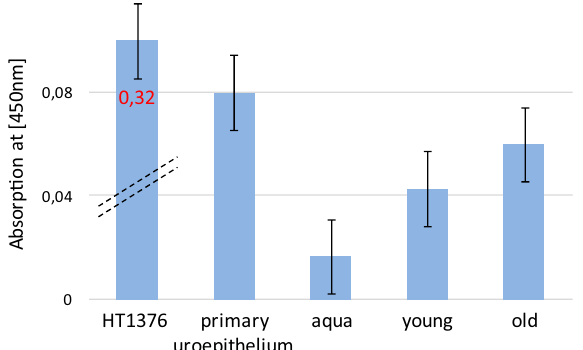
Figure 4. ELISA analysis of LINE-1 ORF-1 product on peripheral blood of young and older individuals. Cell lysate from the urothelial bladder cancer cell line HT1376 and primary urothelium were used together with water and blood plasma from young and older individuals.